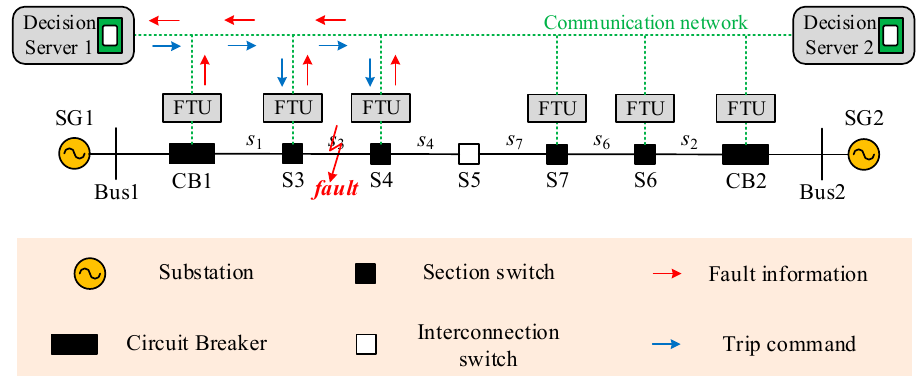
Figure 1. Distribution network fault location system based on FTU fault information.